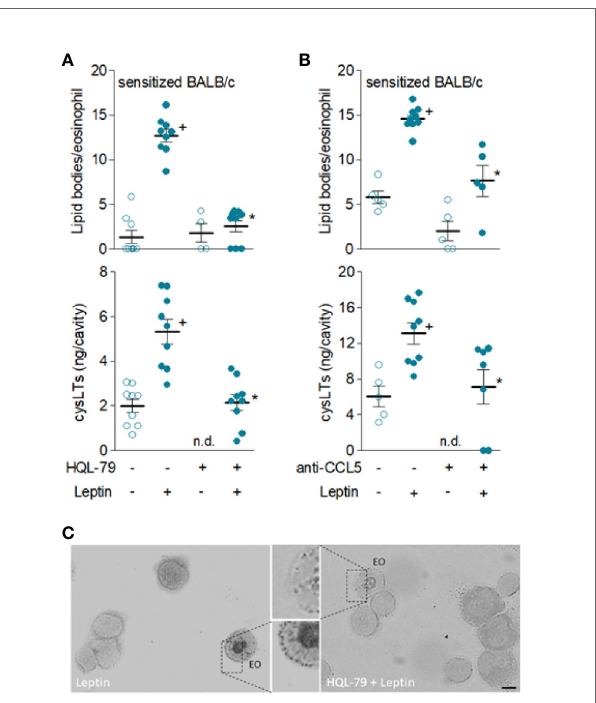
FIGURE 6 | Leptin-induced in vivo eosinophil activation in sensitized BALB/c mice is mediated by PGD 2 and CCL5. Sensitized BALB/c mice received i.pl. injection of leptin (1 mg/kg) and pleural fl uids were collected within 24 h of stimulation. While in (A) , animals were pre-treated with HQL-79 (1 mg/kg, i.p.), in (B) mice were pre-treated with a neutralizing anti-CCL5 antibody (10 µg/cavity, i.pl.). Analyses include numbers of cytoplasmic lipid bodies counted within osmium-stained pleural eosinophils (upper panels) and cysLTs levels found in cell-free pleural fl uids measured by speci fi c EIA kit (bottom panels). (C) shows representative images of osmium-stained pleural cells recovered from leptin-stimulated sensitized BALB/c mice which were pre-treated or not (as indicated) with HQL-79. Values are expressed as the mean ± SEM (experiments were repeated at least once). + p < 0.05 compared to control group and * p < 0.05 compared to leptin-stimulated group. n.d.; not determined. EO; eosinophil. Scale bar = 5 µm.